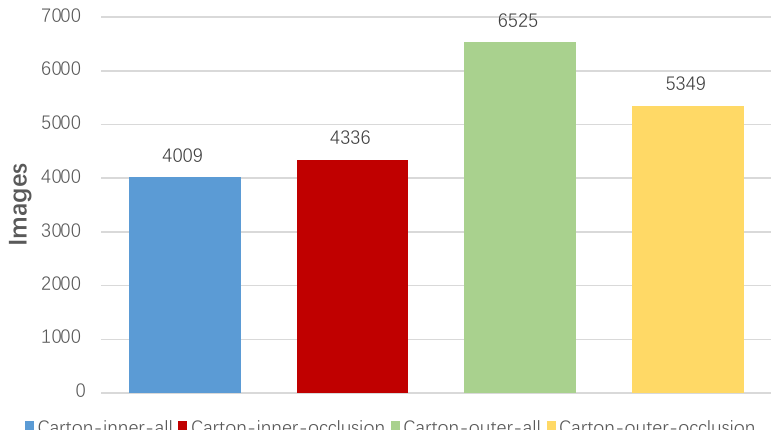
Figure 2. The numbers of instances with respective to four labels in the LSCD, which includes Carton-inner-all, Carton-inner-occlusion, Carton-outer-all, and